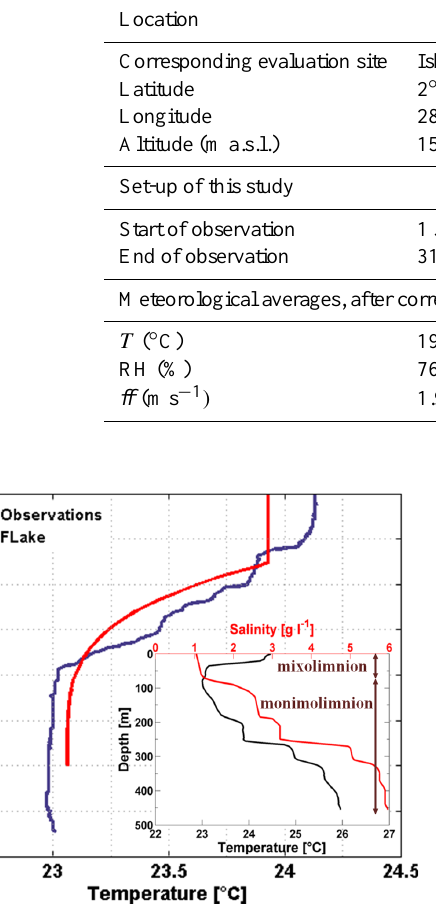
Fig. 2. Water temperature recorded at Ishungu on 21 April 2009 and corresponding FLake midday temperature profile, the latter with its distinct two-layer structure (mixed layer and thermocline). In- set: temperature (black) and salinity (red) profile representative for the main basin during February 2004, as reported by Schmid et al. (2005). For Lake Kivu, the artificial lake depth set in FLake cor- responds to the mixolimnion depth, hence the monimolimnion has no counterpart in FLake. Note the strong increase in salinity from 60–70m downwards, i.e. below the